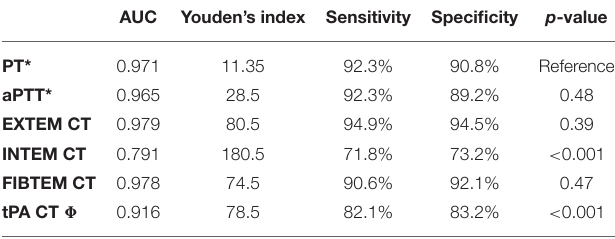
TABLE 2 | ROC analysis for anticoagulant